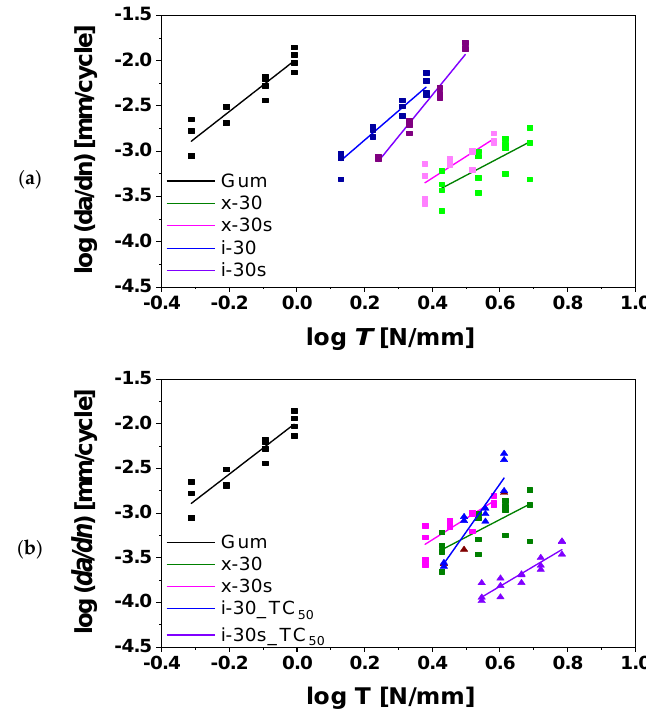
Figure 8. ( a ) Paris plots showing the crack propagation rate as a function of tearing energy for in-situ silica and precipitated silica-filled composites and ( b ) crack propagation of equally adjusted crosslink density of in-situ silica and precipitated silica compounds.